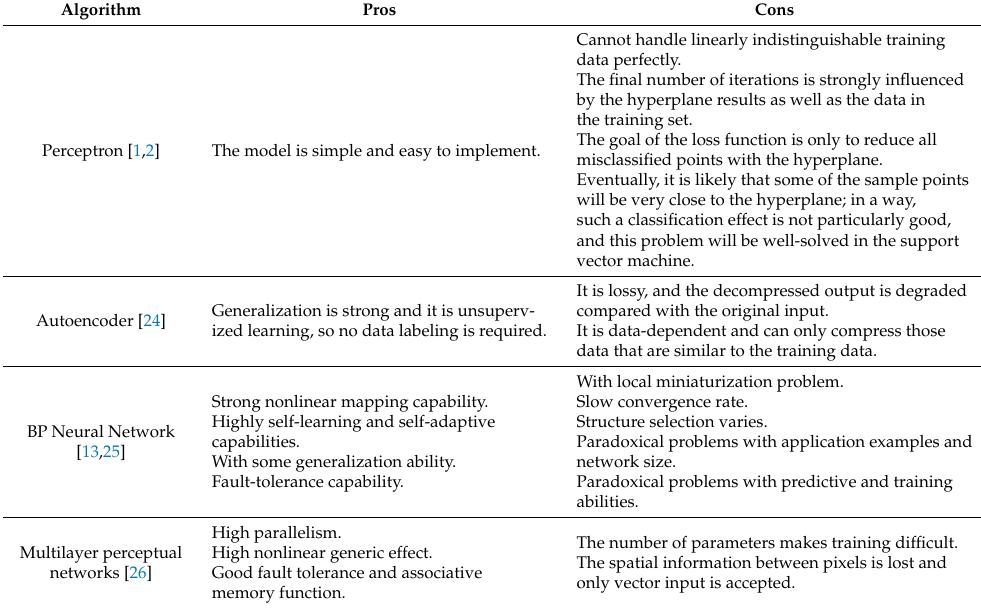
Table 2. Comparison of different artificial neural network models for intelligent identification of